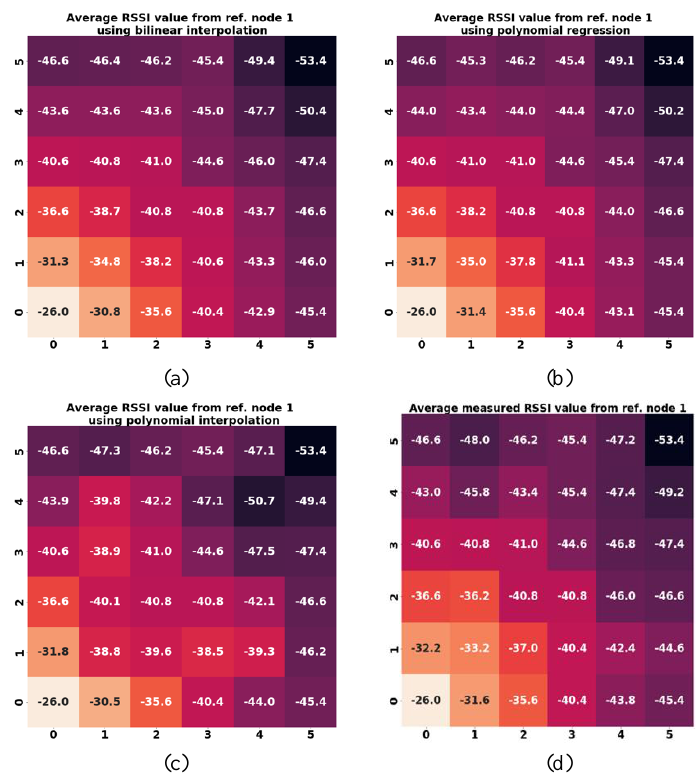
Figure 16. RSSI heatmap reference node 1: a) Bilinear inter., b) Polynomial reg., c) Polynomial inter., d) Measurement.